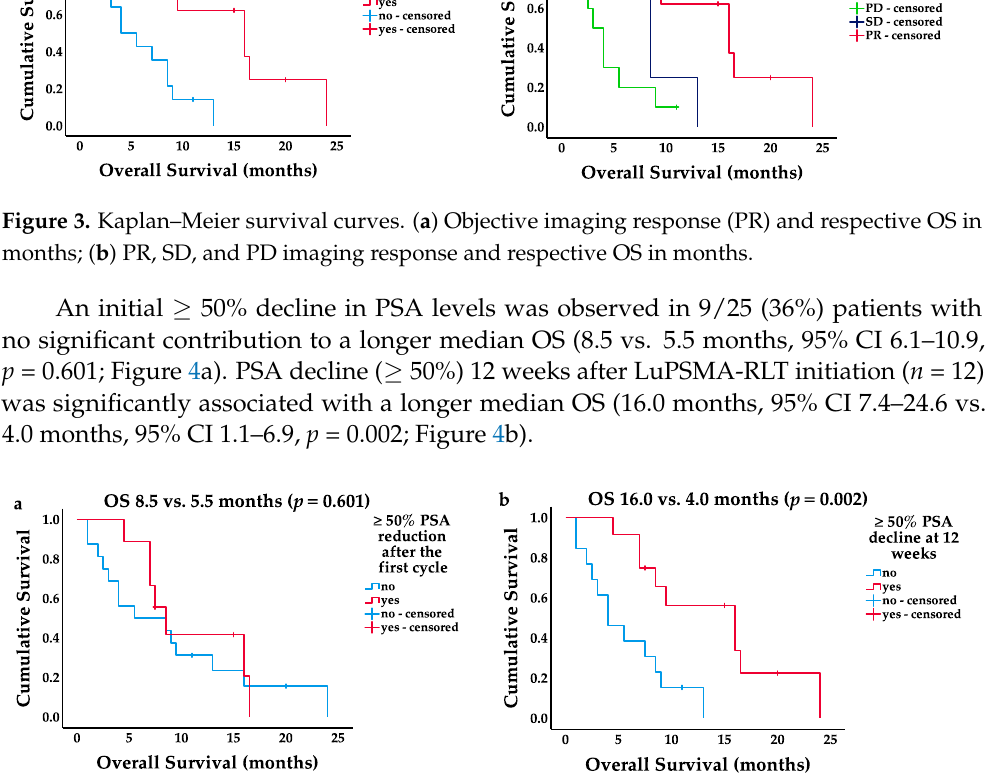
Figure 4. Kaplan–Meier survival curves. ( a ) PSA decline ( ≥ 50%) after the first cycle and respective OS in months; ( b ) PSA decline ( ≥ 50%) 12 weeks after LuPSMA-RLT initiation and respective OS in months.